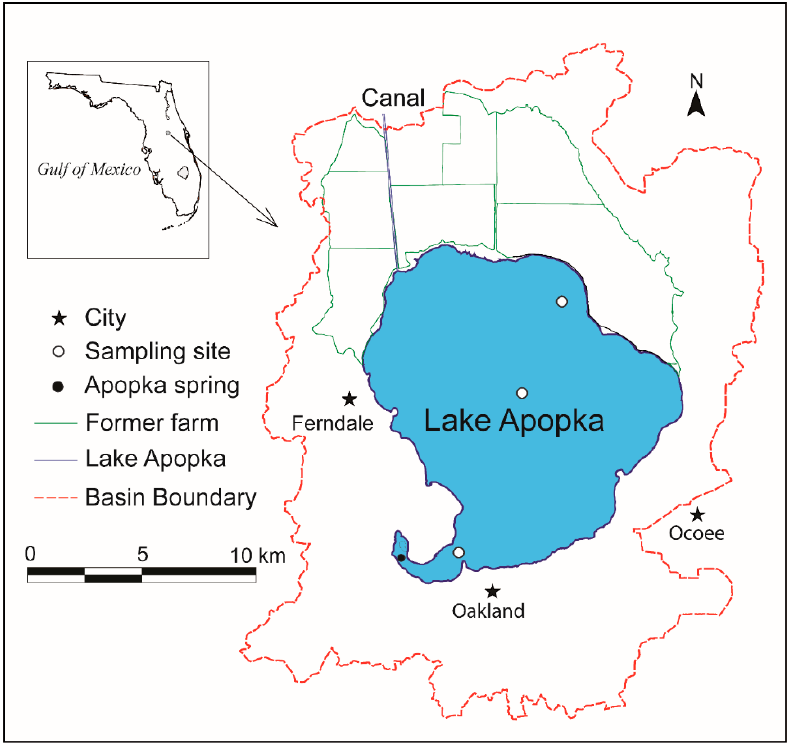
Figure 1. Lake Apopka in Florida, USA, indicating the three pelagic sampling sites, the boundary of the drainage basin, and the former farms that are wetlands now.